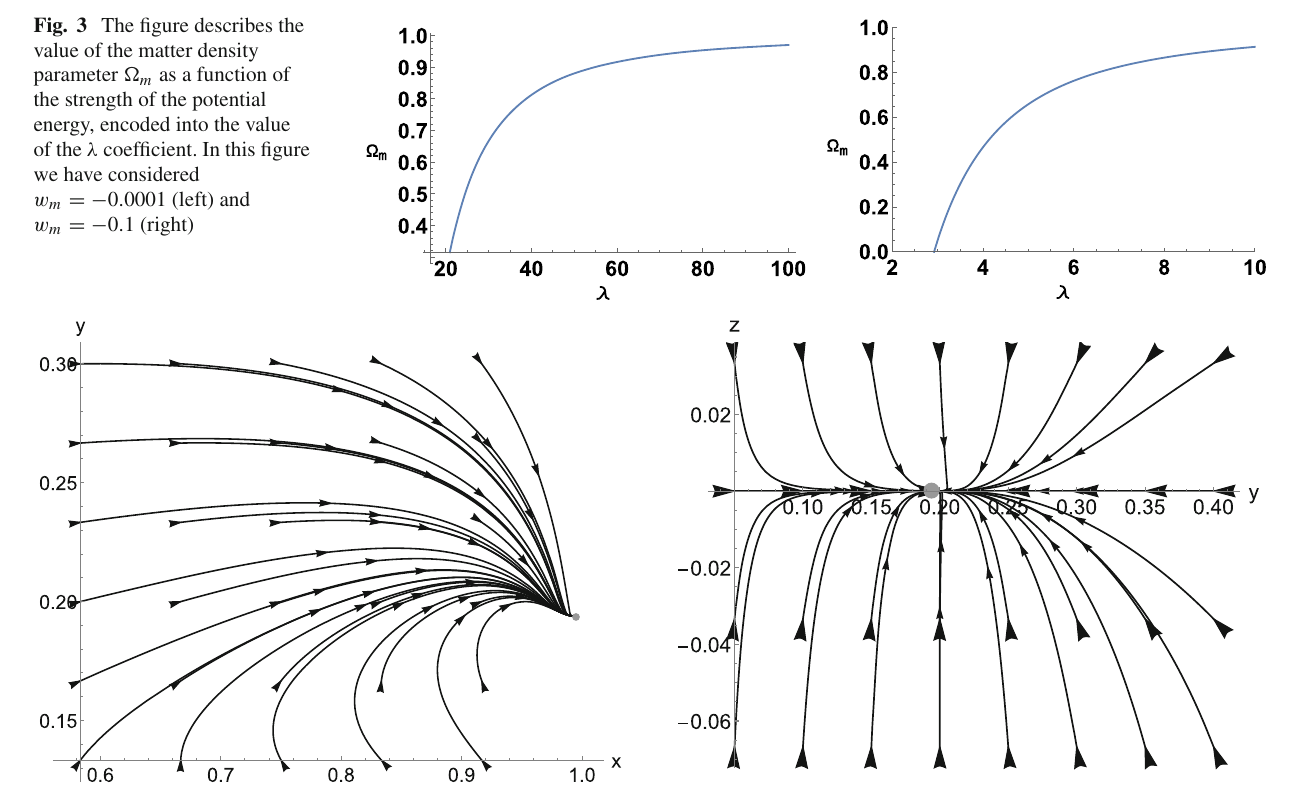
Fig. 6 The evolution towards A in the { y , z } plane